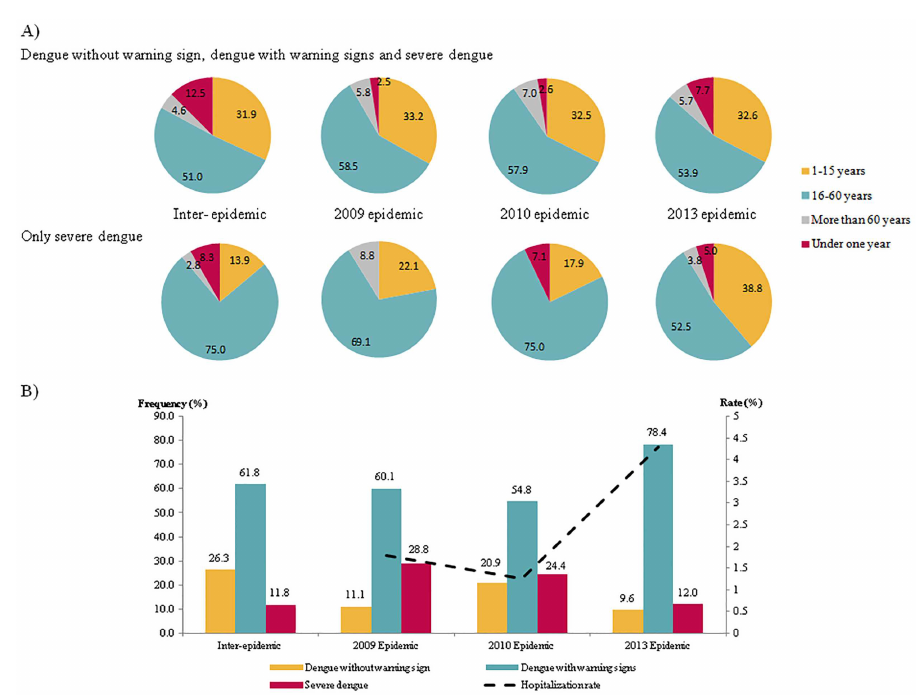
Fig 2. Distribution of epidemiological features according to the three outbreaks, (n = 1356), French Guiana, 2008–2013. A) Age distribution of individualsby epidemic.B) Distributionof categoriesbasedon 2009 WHO criteria and hospitalization rates.